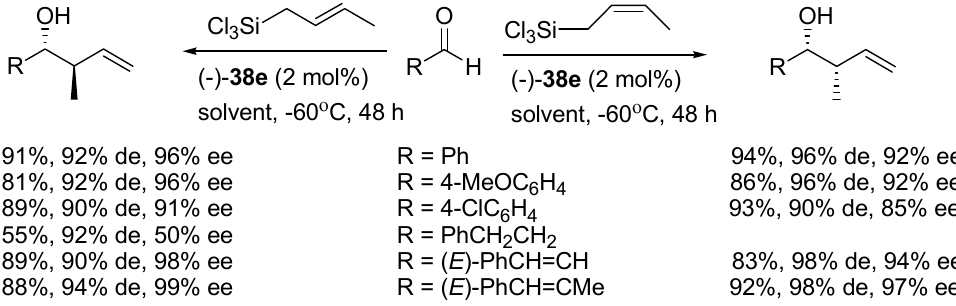
(-)-elisabethadioneon 5 mmol scale Scheme 10. Crotylation with 38e in the total synthesis of (-)-elisabethandione [14]. Compounds 37 were also applied in aldol reaction of acetophenone with trichlorosilyl ketene acetal (Scheme 11) [24]. Good to excellent yields were achieved using 37a , b catalysts, independently of their configuration (87–96%). For 37a , enantioselectivity was higher when ( aS , S , S )-isomer was used and for 37b , c with ( aR , S , S )-isomer. The difference between the structure of catalysts is the presence